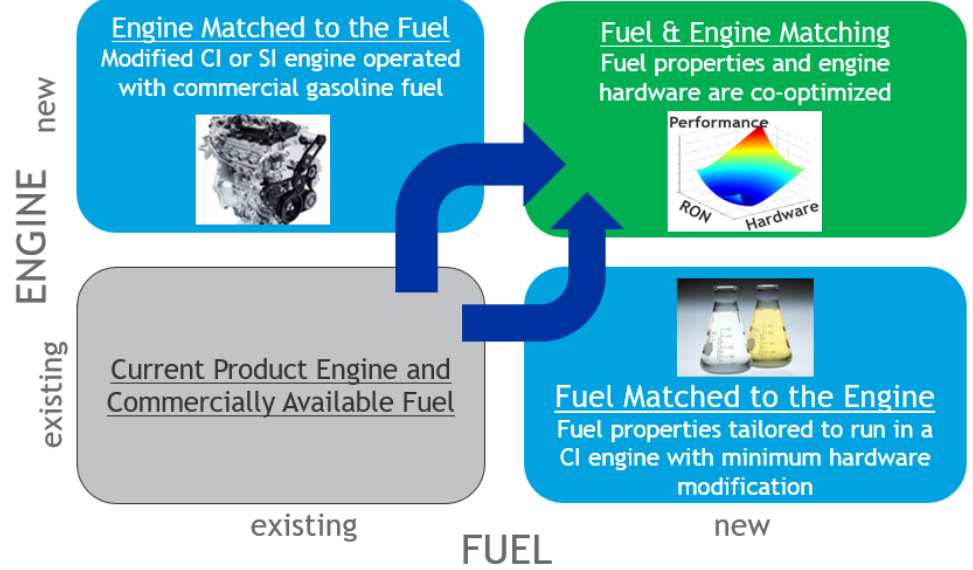
Figure 1. GCI pathway towards fuel and engine co-optimization.